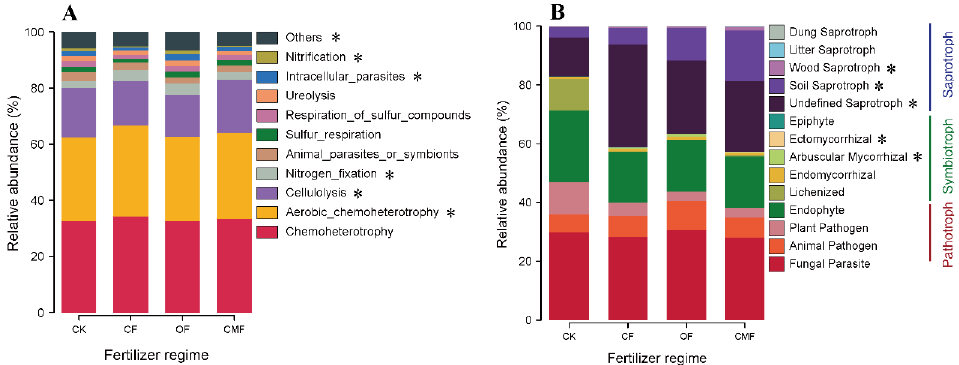
Figure 2. Relative abundances of dominant soil bacterial function ( A ) and fungal guilds ( B ) under four fertilizer regimes. CK, CF, OF, and CMF represent the control, compound fertilizer, organic fertilizer, and compound microbial fertilizer, respectively. The top 10 most abundant bacterial functions were identified and the rest of them were grouped into “Others”. The asterisk indicates the significant differences among different fertilizer